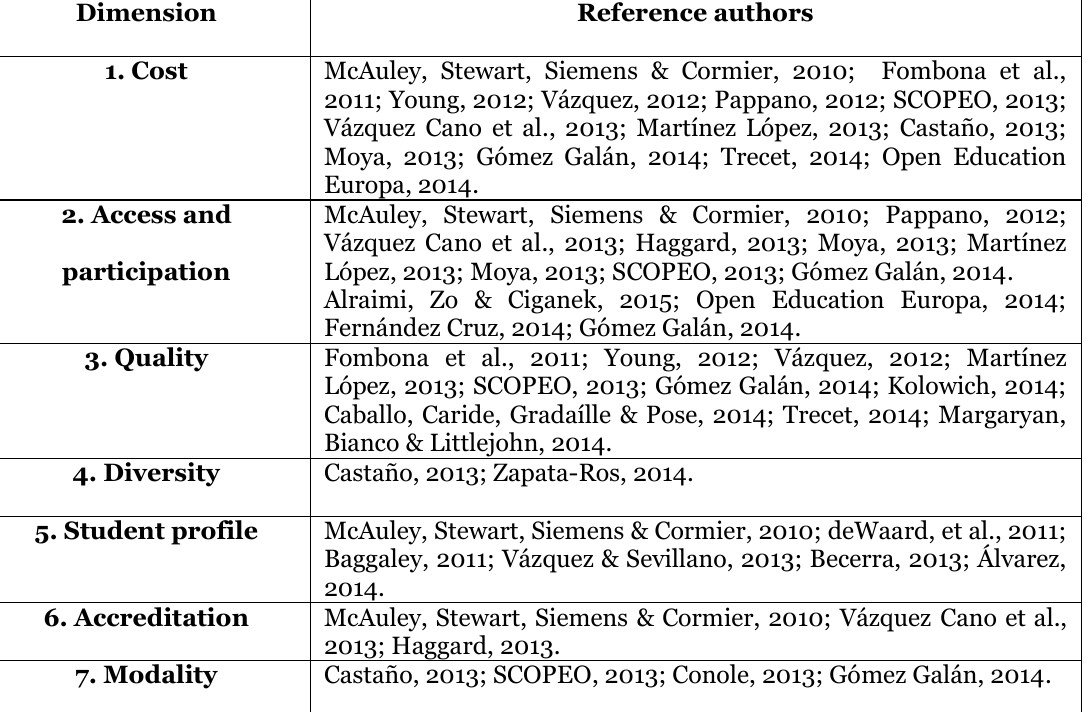
List of Dimensions Relating to New Massive Open Online Courses Dimension Reference